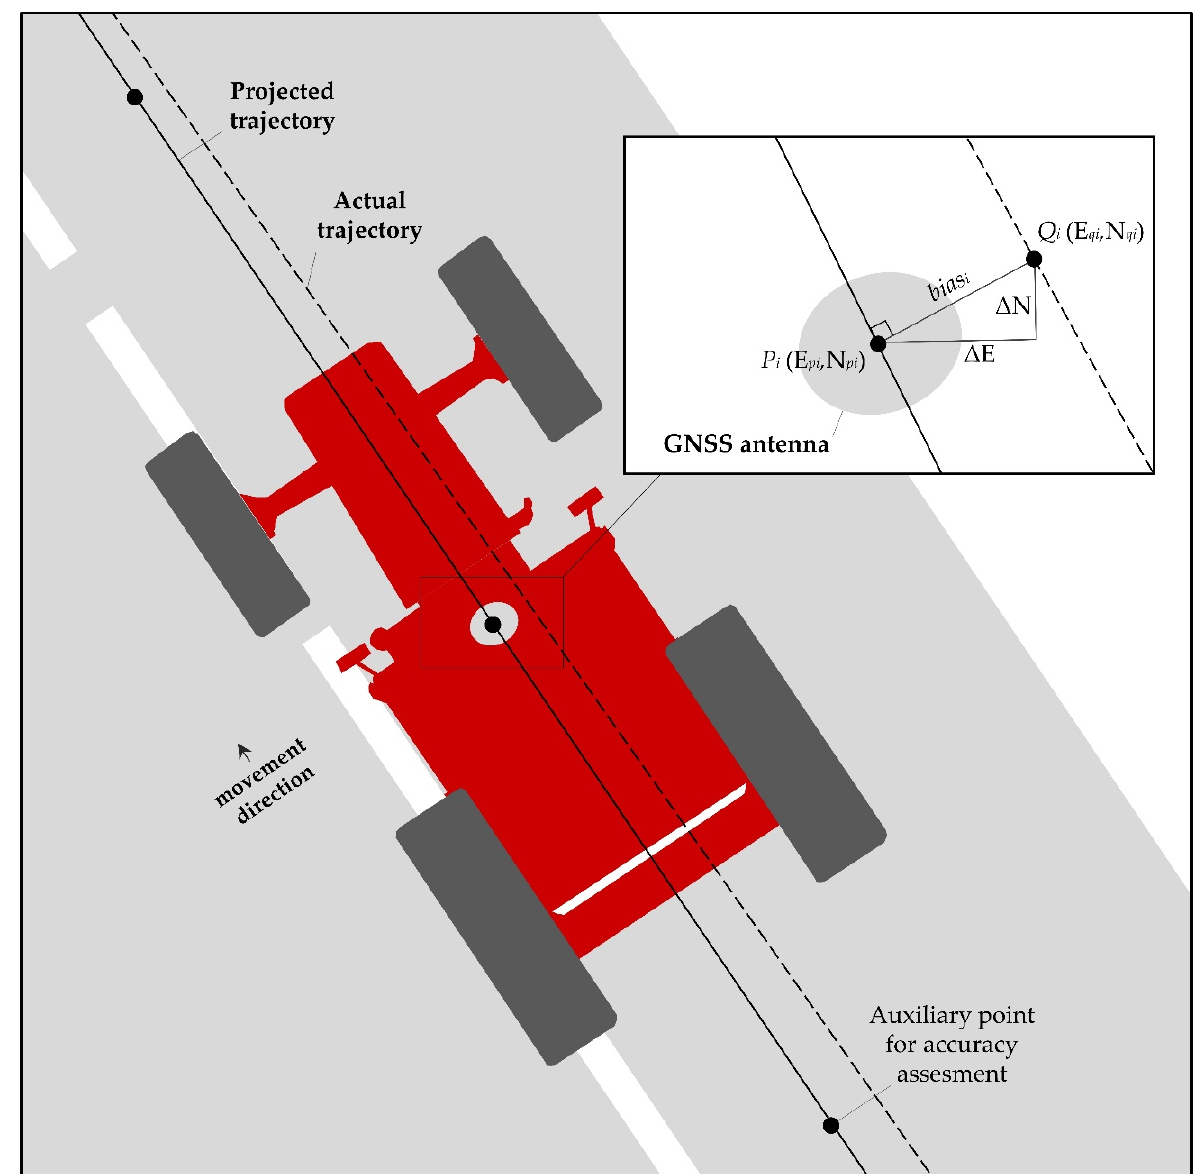
Figure 4. Determination of GNSS positioning accuracy according to the projected trajectory.